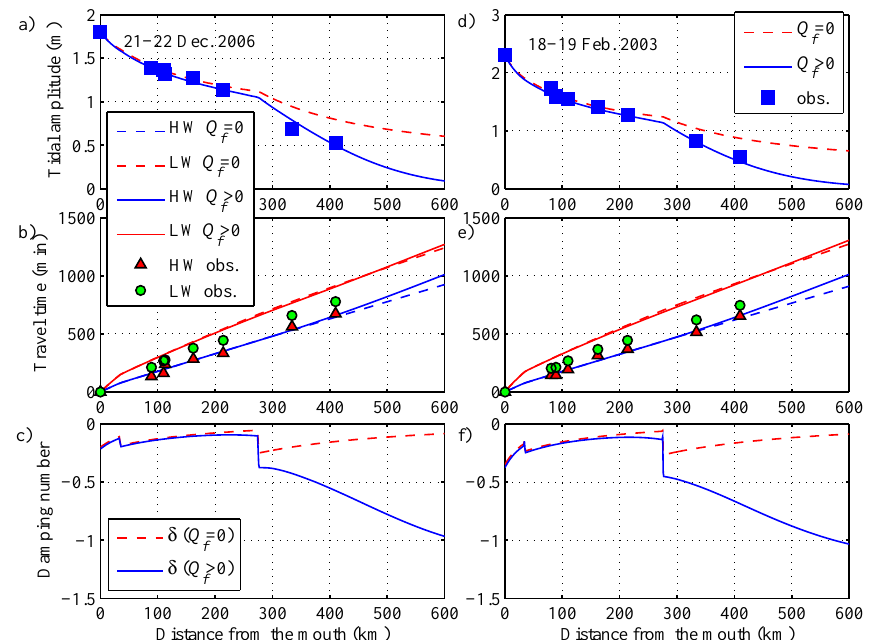
Fig. 10. Comparison of analytically calculated tidal amplitude (a, d) , travel time (b, e) with measurements and comparison of two analytical models to compute the dimensionless damping number (c, f) on 21–22 December 2006 (calibration) and 18–19 February 2003 (validation) in the Yangtze estuary. The dashed line represents the model where river discharge is neglected. The continuous line represents the model accounting for the effect of river discharge. Both models used the same friction coefficients calibrated while considering river discharge.